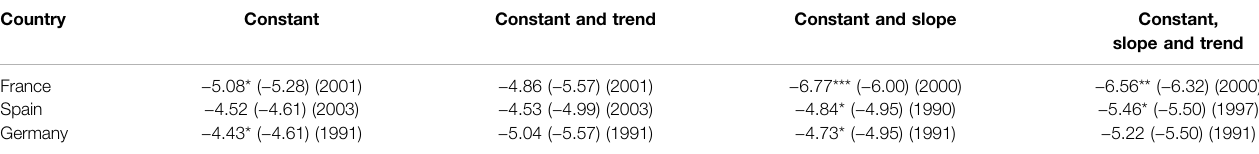
slope and trend